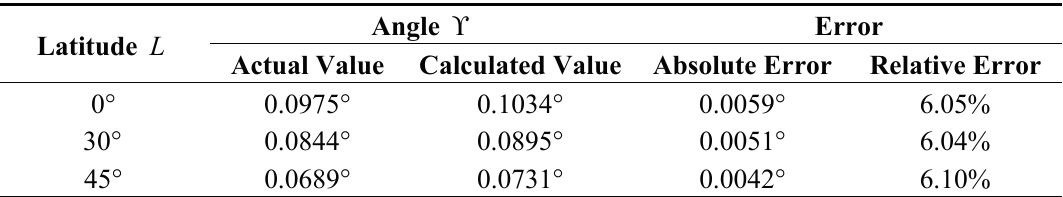
Table 5. The difference between calculated ϒ and actual ϒ